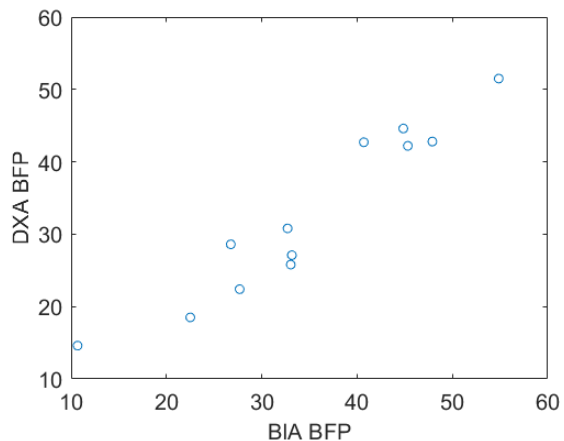
Figure 1. Relation between the DXA BFP and BIA BFP. BFP—body fat percentage; DXA—dual energy X-ray absorptiometry; BIA—Bioimpedance.